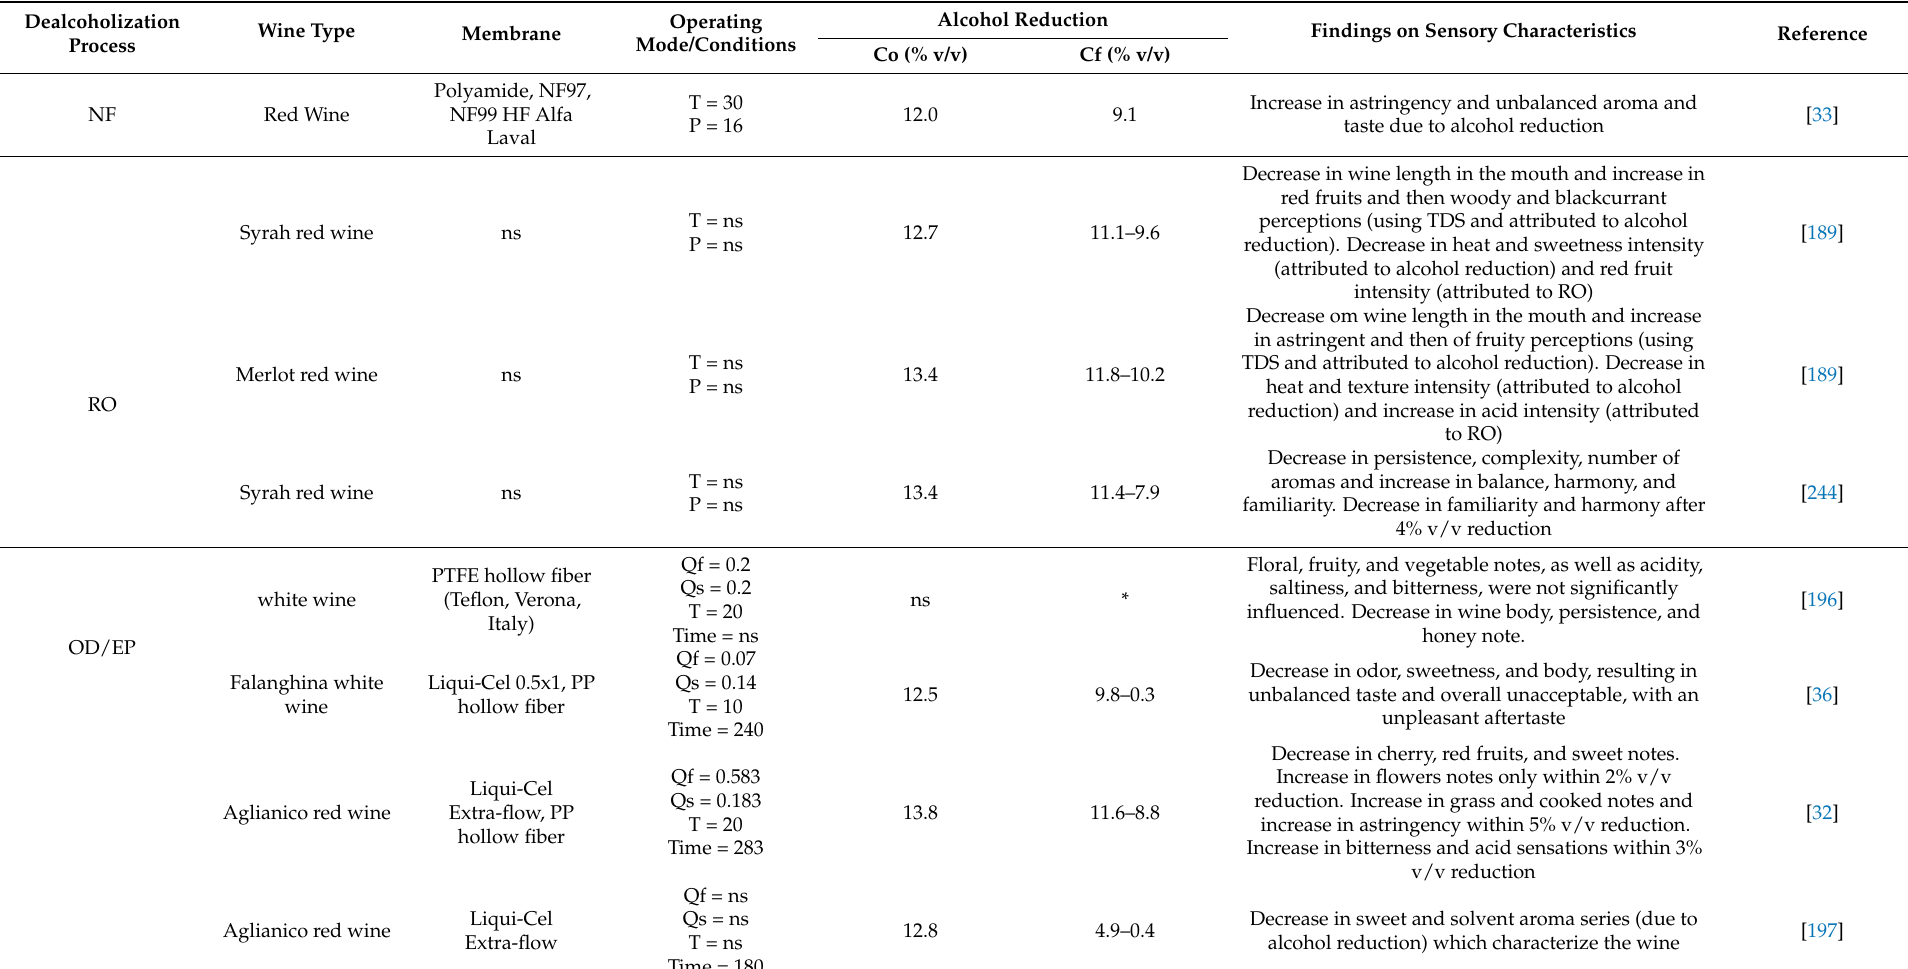
Table 4. Summary of the main results of some studies on the sensory changes caused by the removal of ethanol from wine by various dealcoholization processes. Dealcoholization